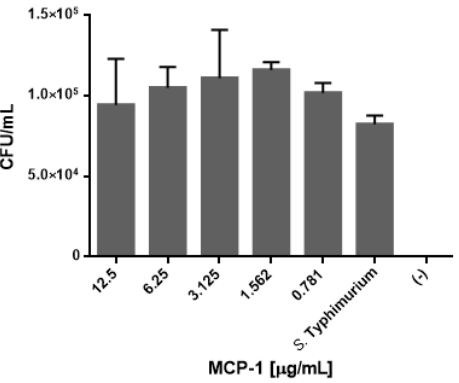
Figure 4. MCP − 1 does not alter the phagocytic activity of RAW 264.7 cells. Macrophages were challenged with different concentrations of MCP-1 (0.78–12.5 µ g/mL) for 18 h and infected with S. Typhimurium for 30 min to evaluate their phagocytic activity ( n = 3). S. Typhimurium: infected cells without MCP-1; Control ( − ): cells without bacteria. This figure shows the average of three independent experiments (statistically non-significant).